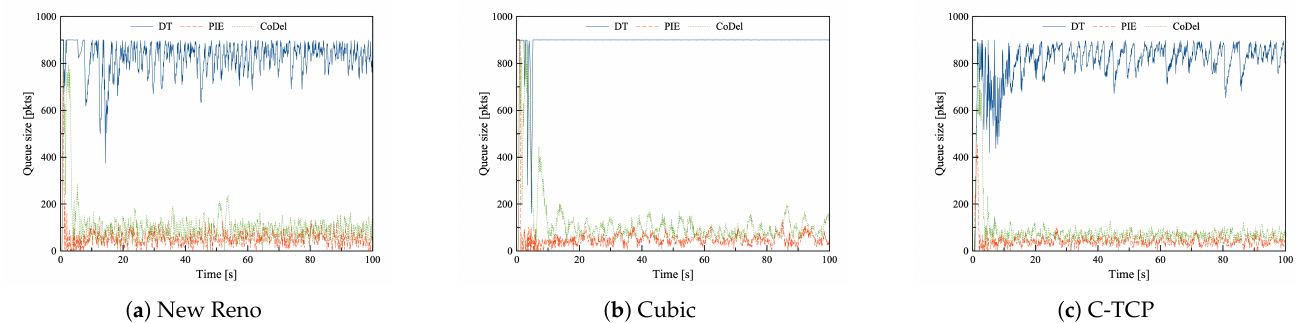
Figure 6. The queue length of DT, PIE and CoDel in combination with ( a ) New Reno, ( b ) Cubic, and ( c ) C-TCP in the Access Link scenario with common TCPs during mild congestion.